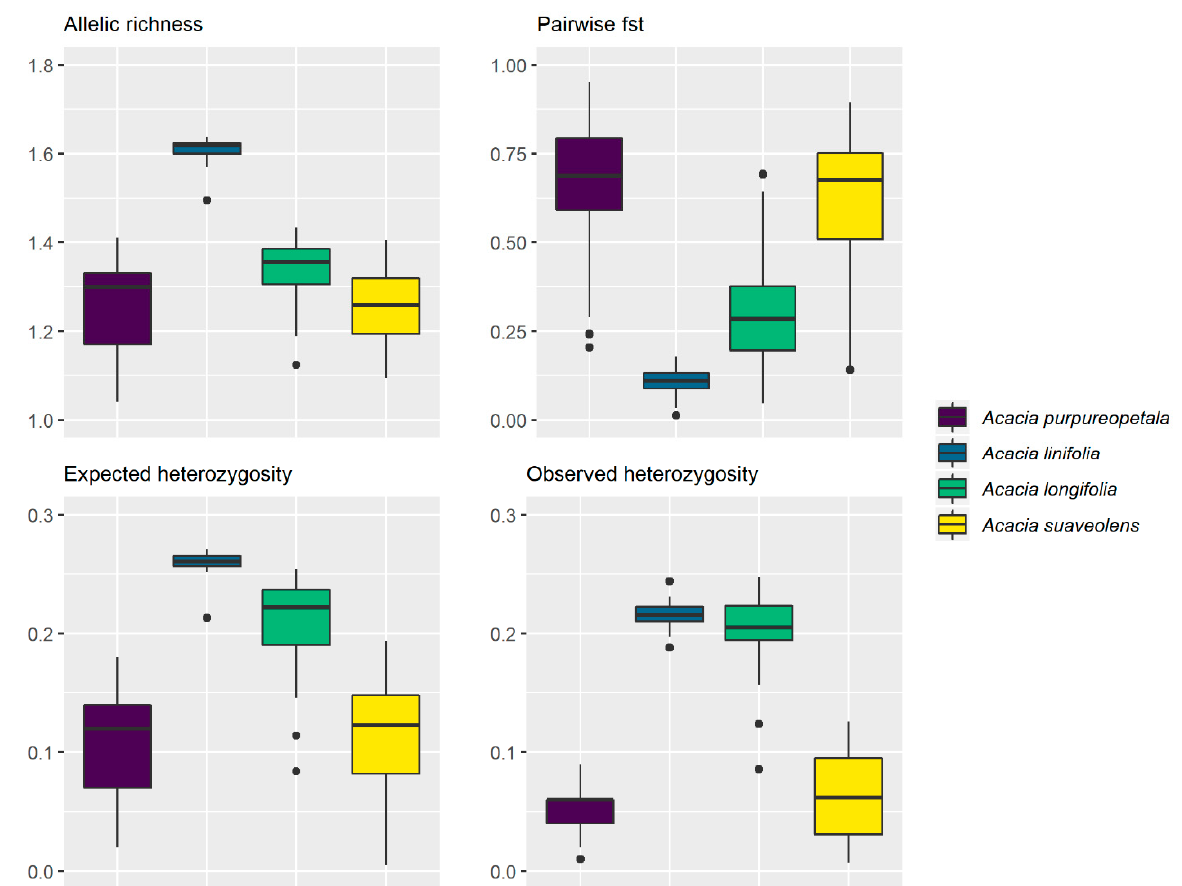
Figure A2. Box whisker plots for genomic diversity measures and pairwise Fst for four Acacia species from SNP data across the known distribution of each species . Details of each measure for A. purpureopetala are provided in Table 2. Table A1. Species diversity across two substrata (taller shrub layer, S1 and lower shrub layer, S2) and the species count for A. purpureopetala across each transect (Ap Transect) and across the field site (Ap site). Field sites appear in the order of numbering on the map in Figure 1.